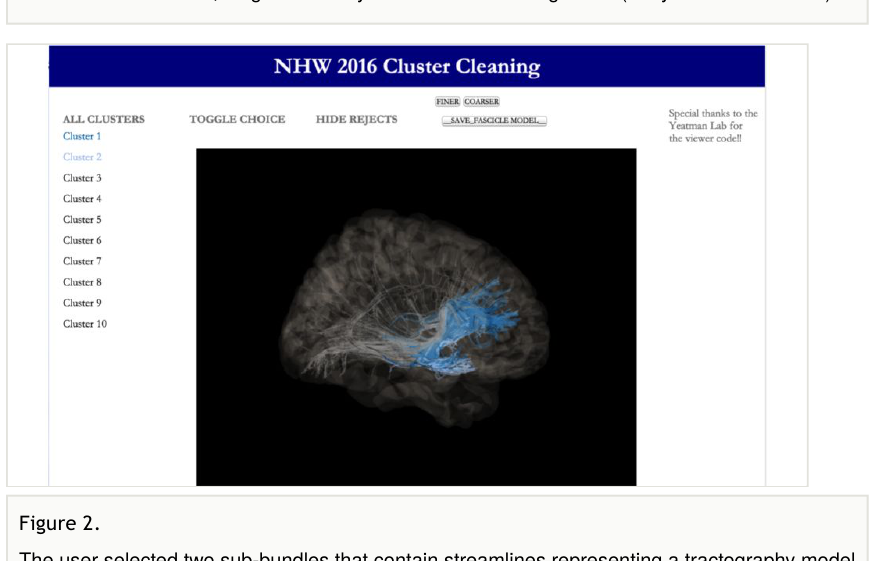
The connectivity of an ROI placed on the coronal plane over the external/extreme capsules at the level of the anterior commissure is shown (tractography method: Caverzasi et al. 2015). Each color is a cluster, as generated by the Quickbundles algorithm (Garyfallidis et al. 2012).